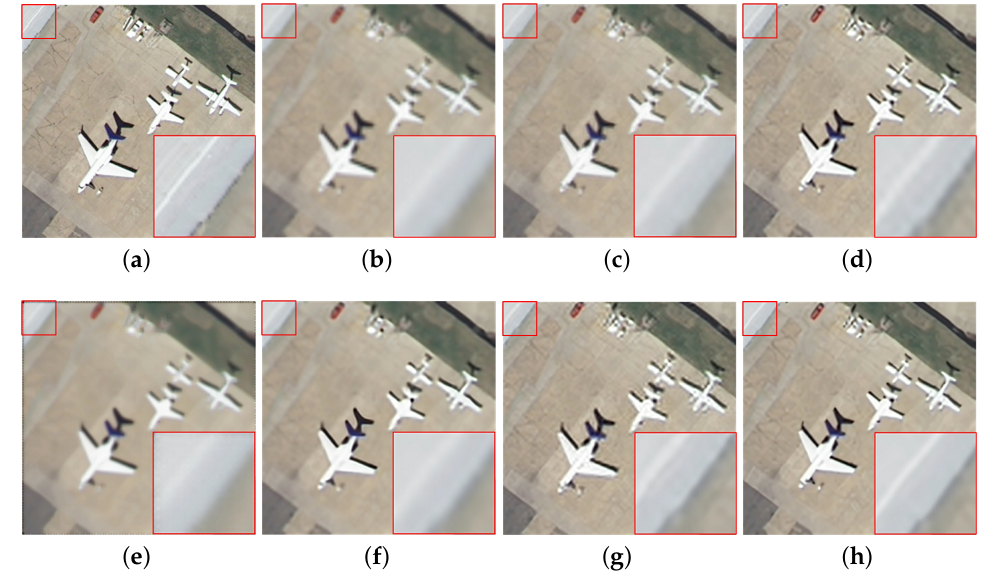
Figure 6. Visual comparisons of the proposed method and other methods on the airplane image (noise = 0). ( a ) original image. ( b ) Bicubic interpolation (PSNR:26.27, SSIM:0.7989, ERGAS:2.6212). ( c ) SRSC (PSNR:26.95, SSIM:0.8205, ERGAS:2.4746). ( d ) ASDS